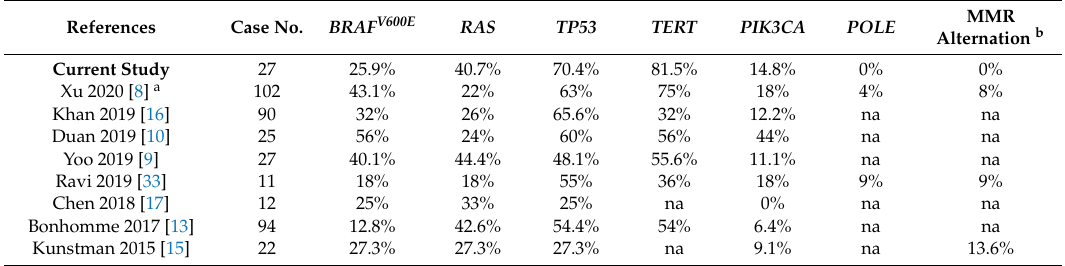
Table 4. Literature review of molecular alternations in anaplastic thyroid